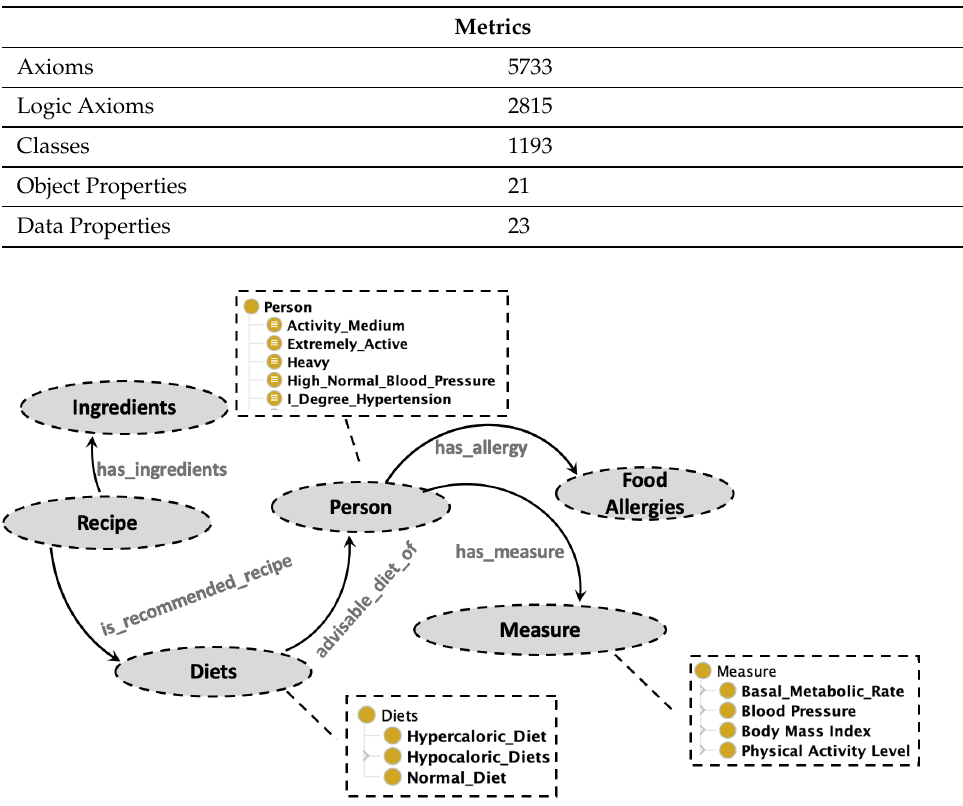
Figure 6. Global hierarchy concepts of the